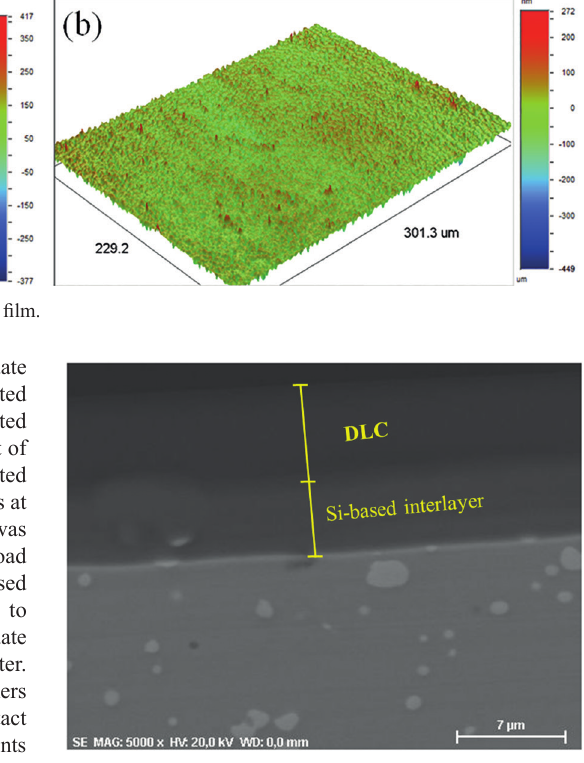
Figure 4: Cross sectional SEM image of DLC film and